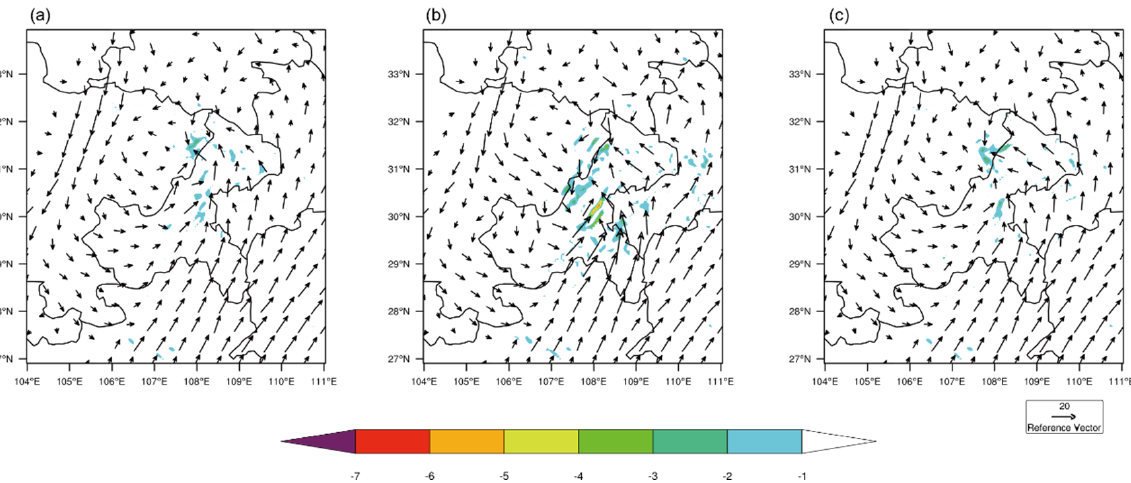
Figure 12. Horizontal wind vector and water vapor flux divergence (shaded; units: 10 − 6 g cm − 2 hPa − 1 s − 1 ) at 850 hPa at 0000 UTC 5 June 2019: ( a ) CTRL; ( b ) ψ−χ control variable; ( c ) U − V control variable.